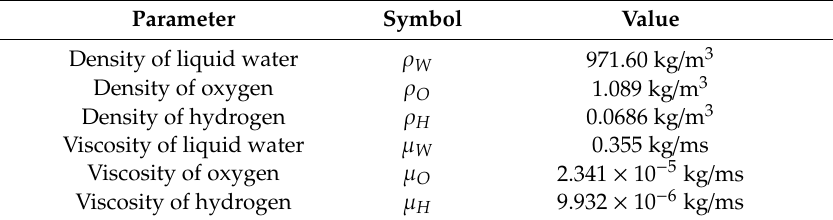
Table 3. Properties of the fluid at 80 ◦